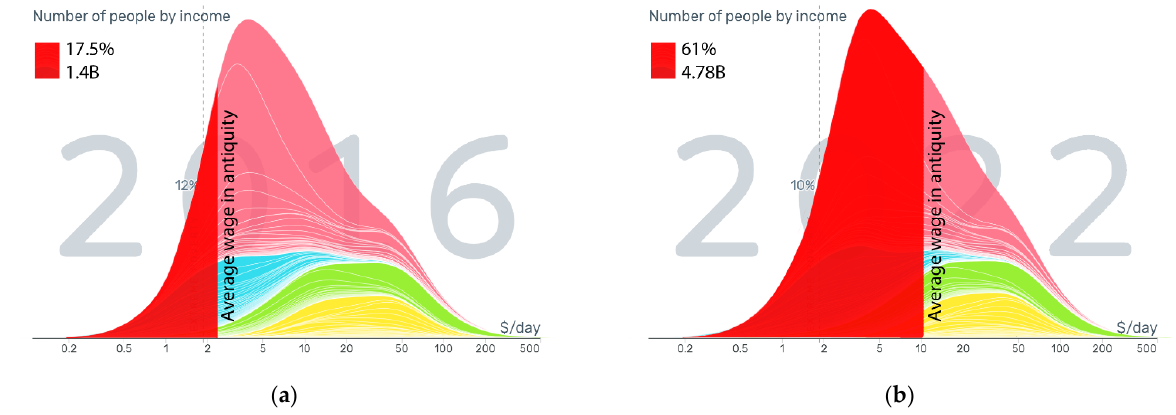
Figure 8. Income mountains (data adapted from [116] after transformation) marking the average wheat wage in antiquity. ( a ) 2016: wheat price average of 2010–2020 was about 210 € per ton; ( b ) 2022: wheat price was about 650 € per ton. Data accuracy is low as prices depend on local markets.